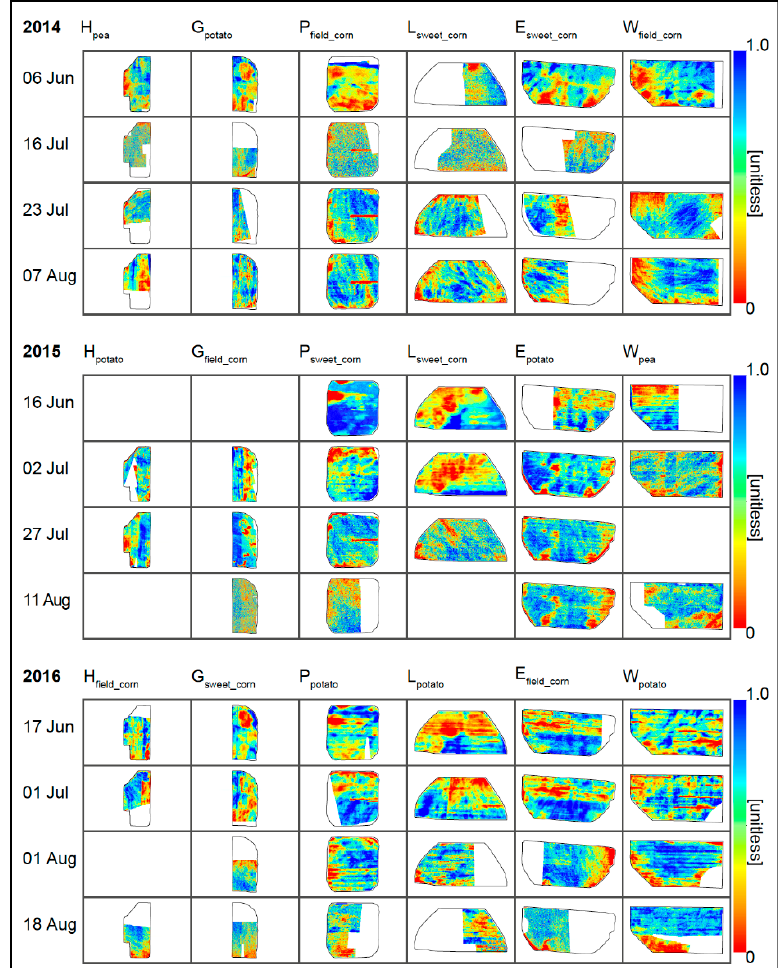
Figure 8. Maps of relative evapotranspiration (ET R , unitless) for fields H, G, P, L, E, and W for 12 airborne missions in 2014–2016. Color bars represent linearly normalized mean ET R rates to the 5th (red) and 95th (blue) percentile for each field. Blank spaces indicate missing imagery because of cloud interference during missions.